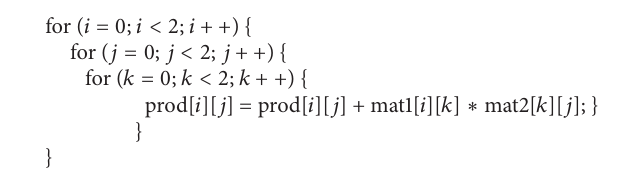
Algorithm 1: For-loop code for 2 × 2 matrix-matrix multiplication in C.